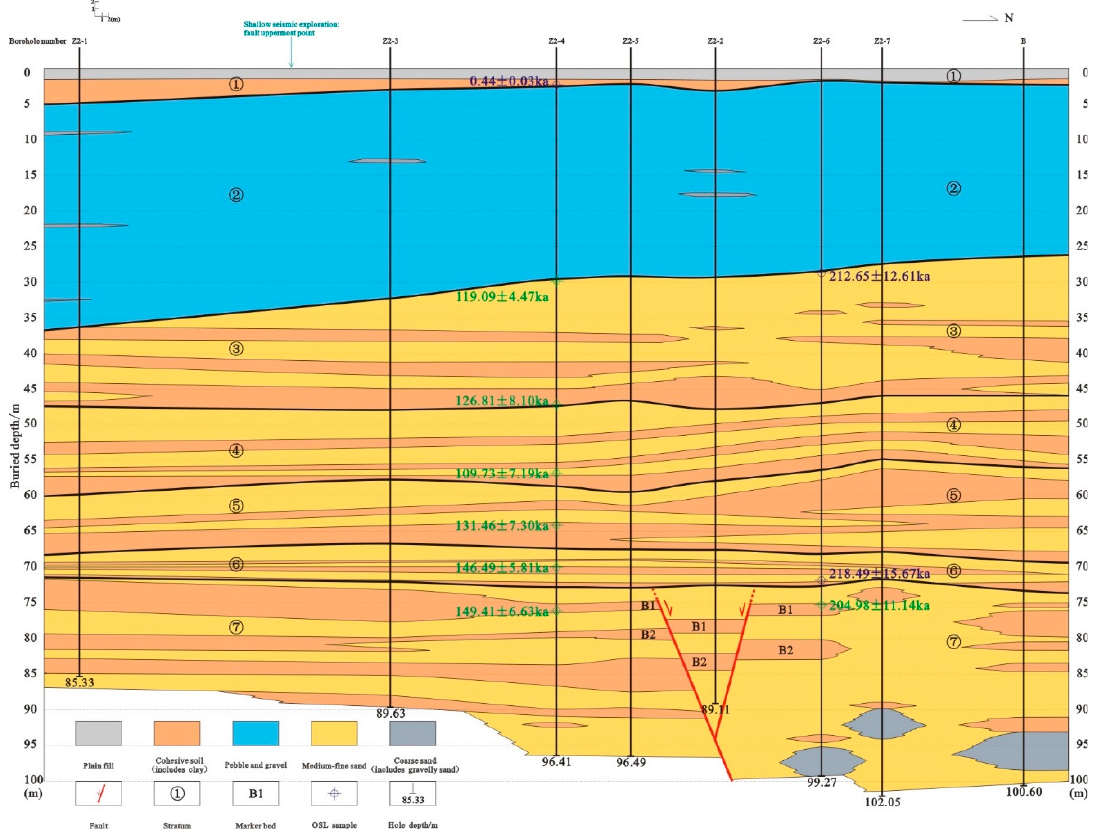
Figure 6. Stratigraphic lithology of composite drilling section in Lizui